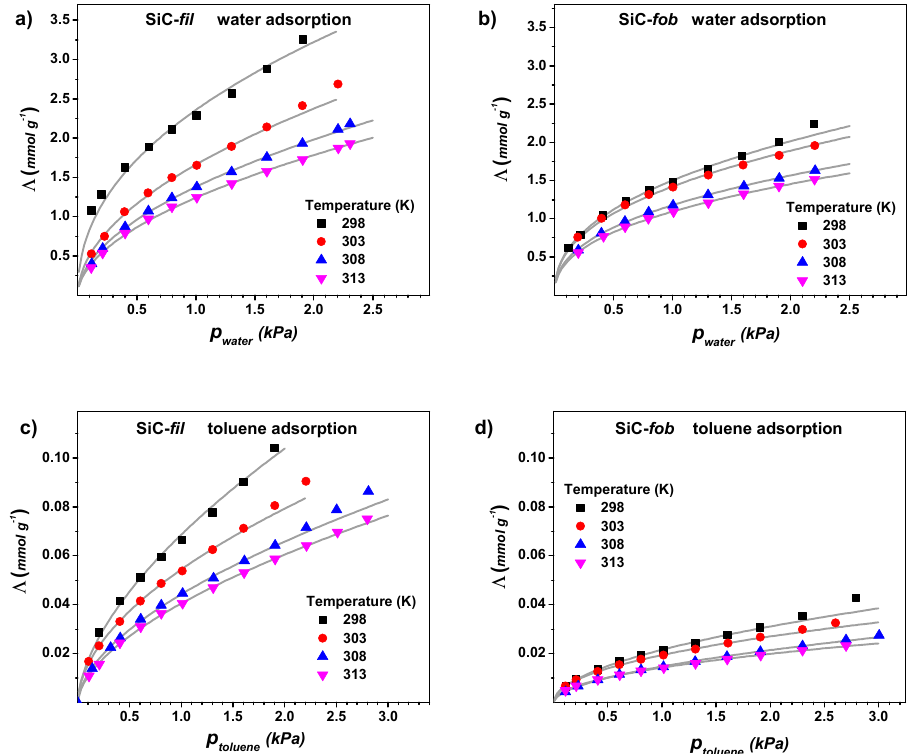
Figure 4. Microgravimetric isotherms for the adsorption of water ( a , b ) and toluene ( c , d ) on SiC- fil and SiC- fob at 298, 303, 308, and 313 K. Grey lines represent the power fitting of vapour uptake ( Λ ) data by the a Freundlich-type power function ( Λ = Λ 1 KPa p 1 n ).